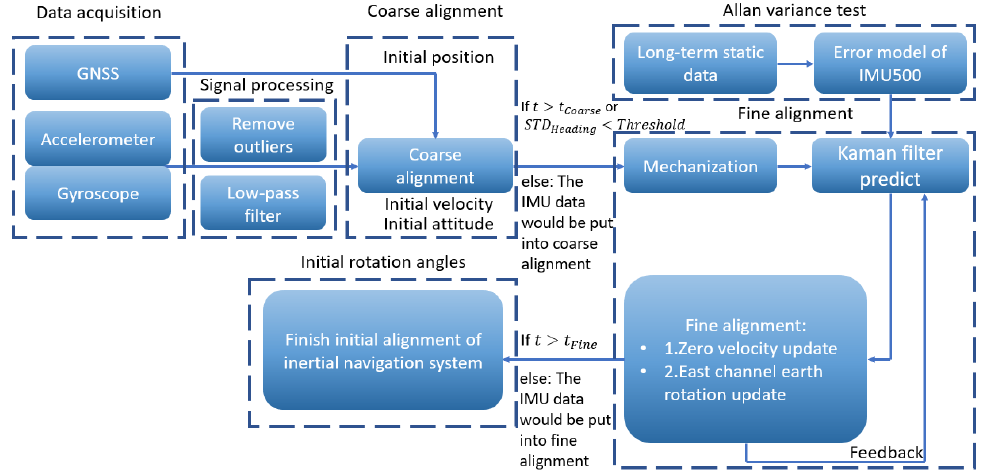
Figure 10 .Flow chart of initial